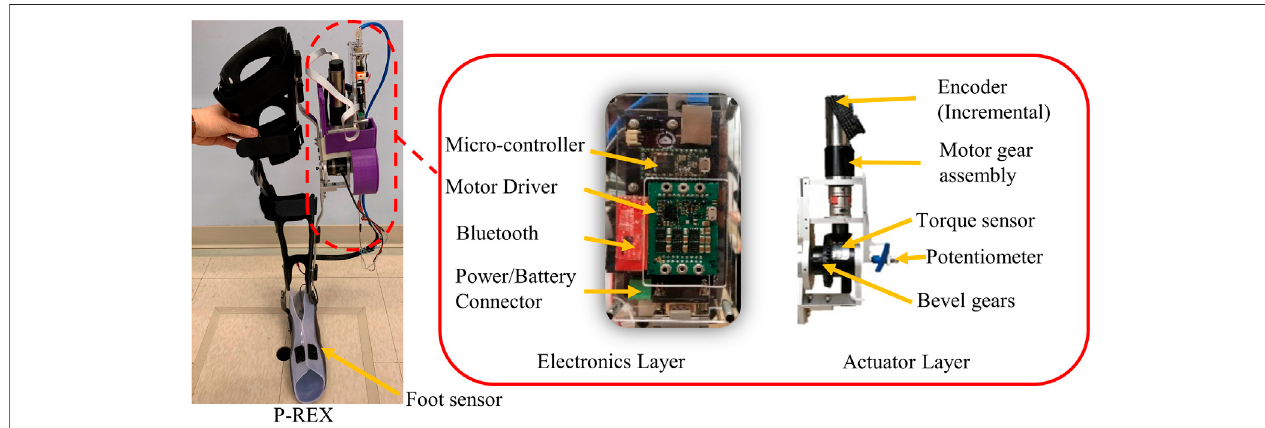
FIGURE 1 | Overview of the pediatric knee exoskeleton (P.REX). The device incorporates a custom actuation assembly and embedded electronic control system mounted on the lateral side of the leg.